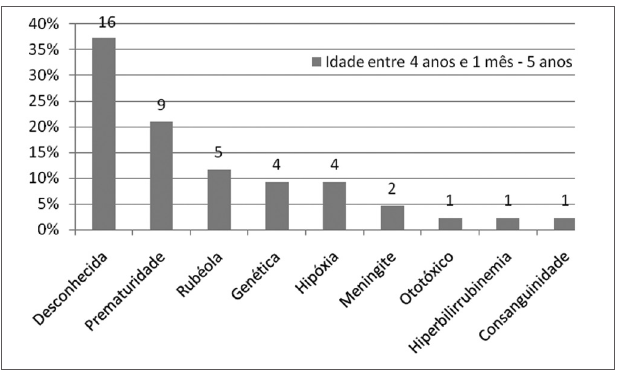
Figura 12. Distribuição etiológica dos pacientes implantados na faixa etária entre 4 anos e 1 mês e 5 anos.